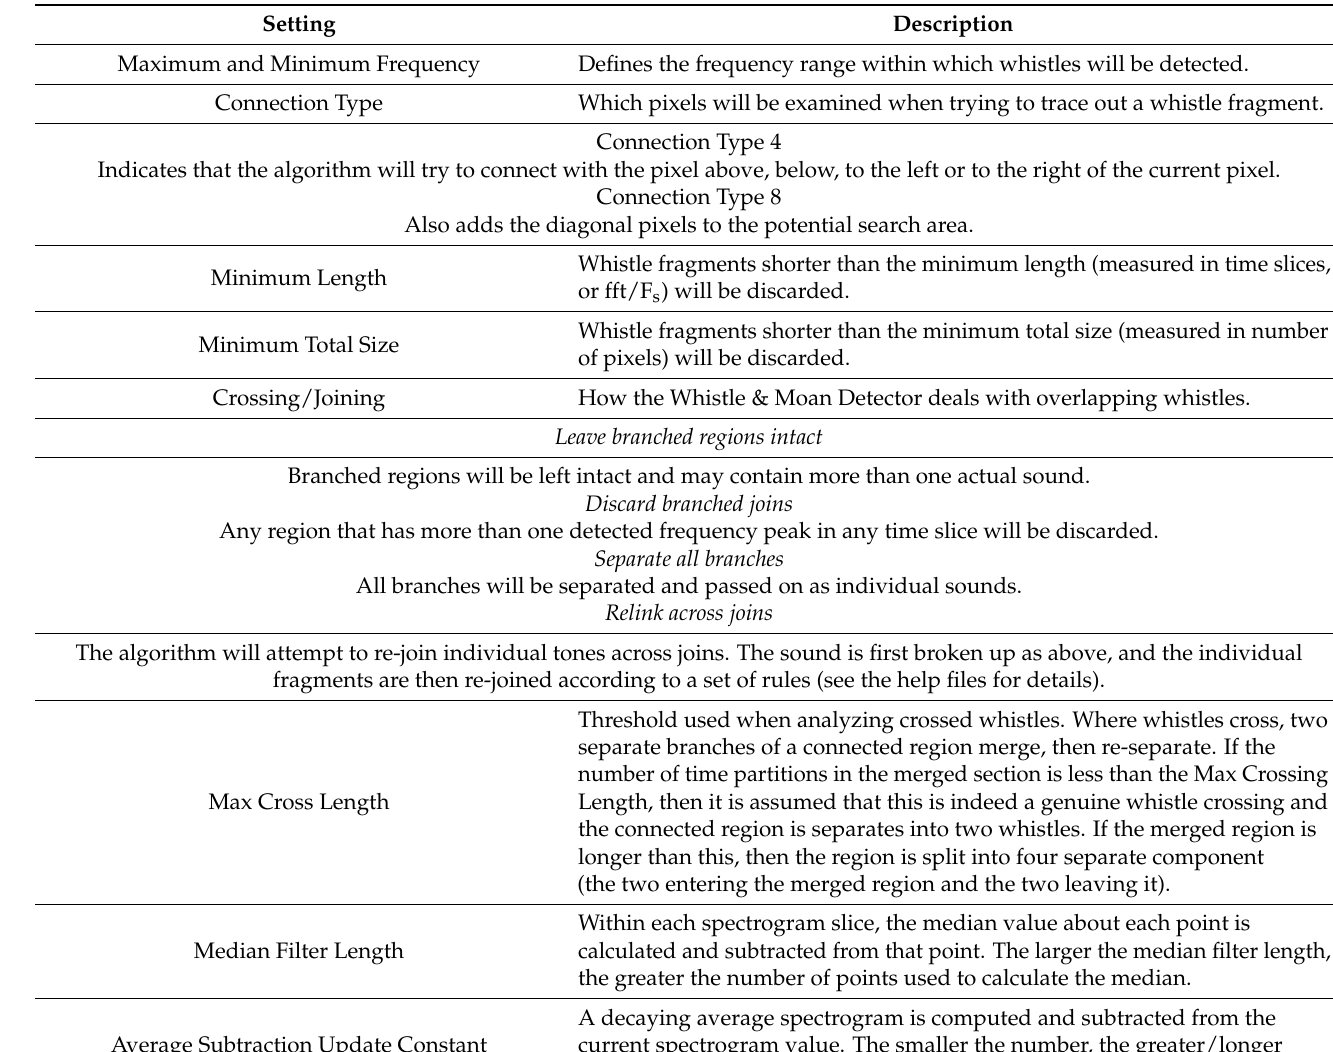
Table A1. Whistle & Moan Parameter Definitions as defined in Gillespie et al. [13]. For additional details please see Gillespie et al.